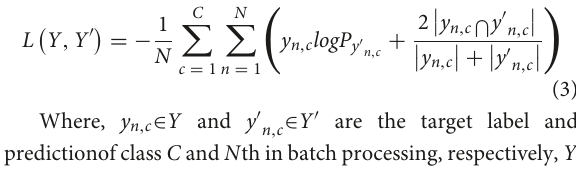
region (30). In other words, the task of 3D-CSN is to classify every pixel on the video volume into LVM or